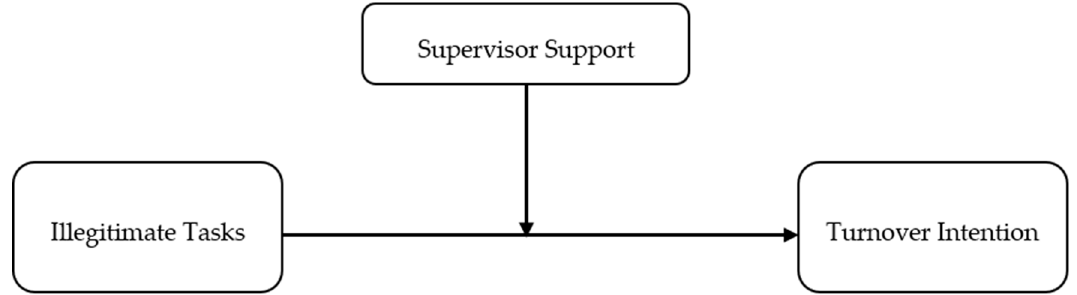
Figure 1. Research framework.